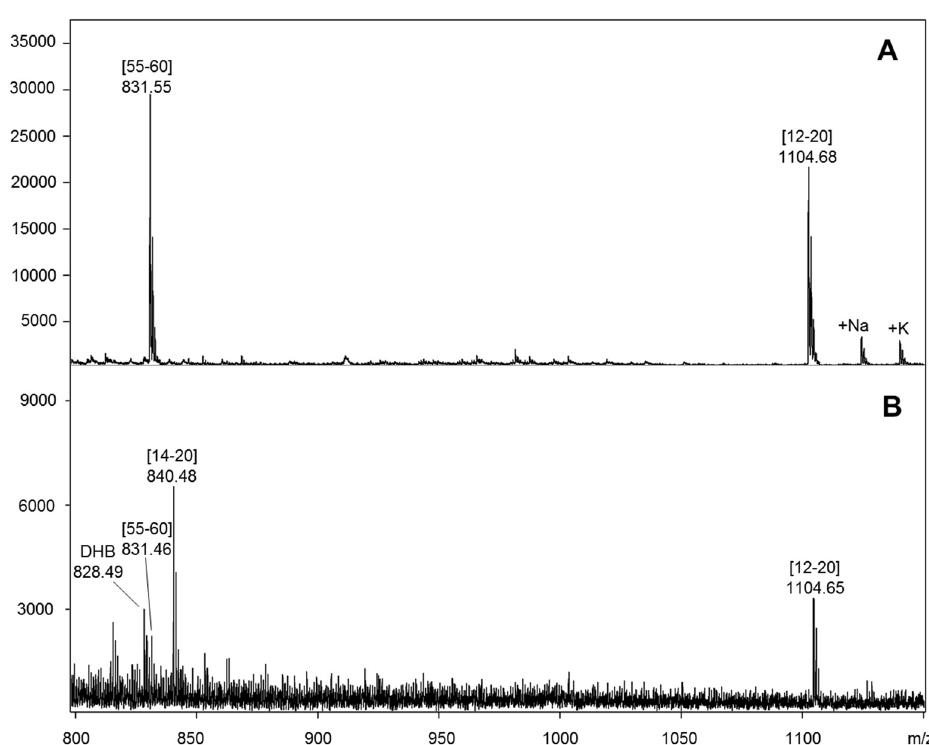
Figure 5. Identification of the interleukin-8 epitope to a monoclonal anti-IL8 antibody by proteolytic extraction MALDI-MS, upon elution of the bound epitopes from a microaffinity column ( A ), and elution from an SPR chip ( B ). The antibody was immobilized by NHS/EDC coupling as described [53]. Epitope elution provided a discontinuous epitope comprising IL-8 sequences (12–20) and (55–60).